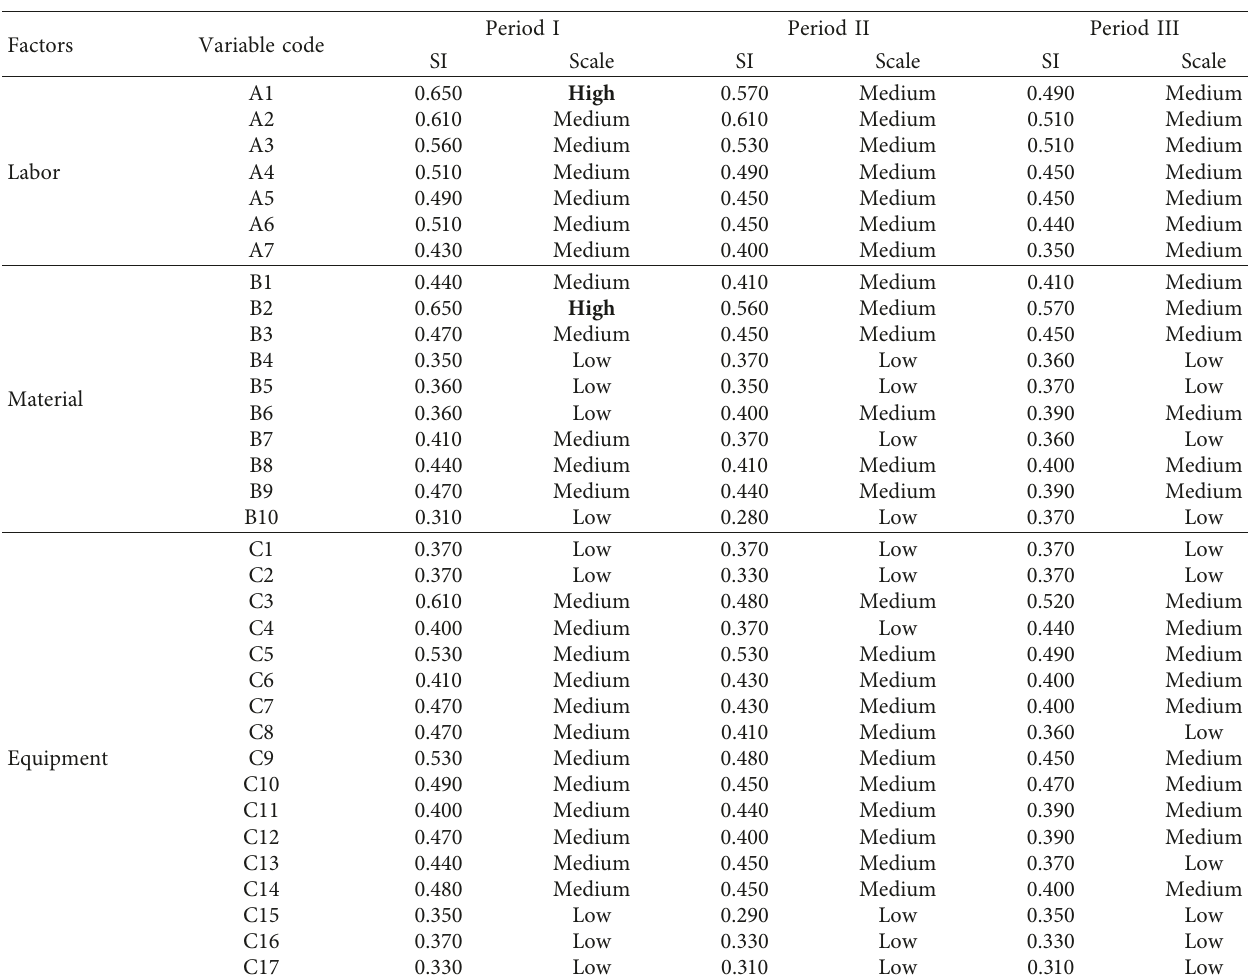
Table 11: Result of the severity index (SI).